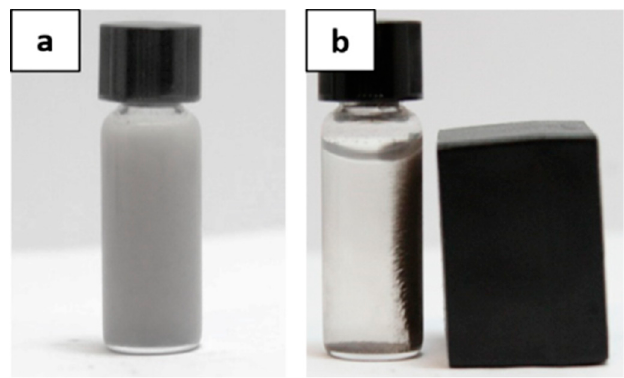
Figure 6. ( a ) Dispersion of CoFe 2 O 4 @ZnS-0.5h photocatalysts, ( b ) the separation of CoFe 2 O 4 @ZnS-0.5h photocatalyst by an external magnet. Figure adapted from [73].